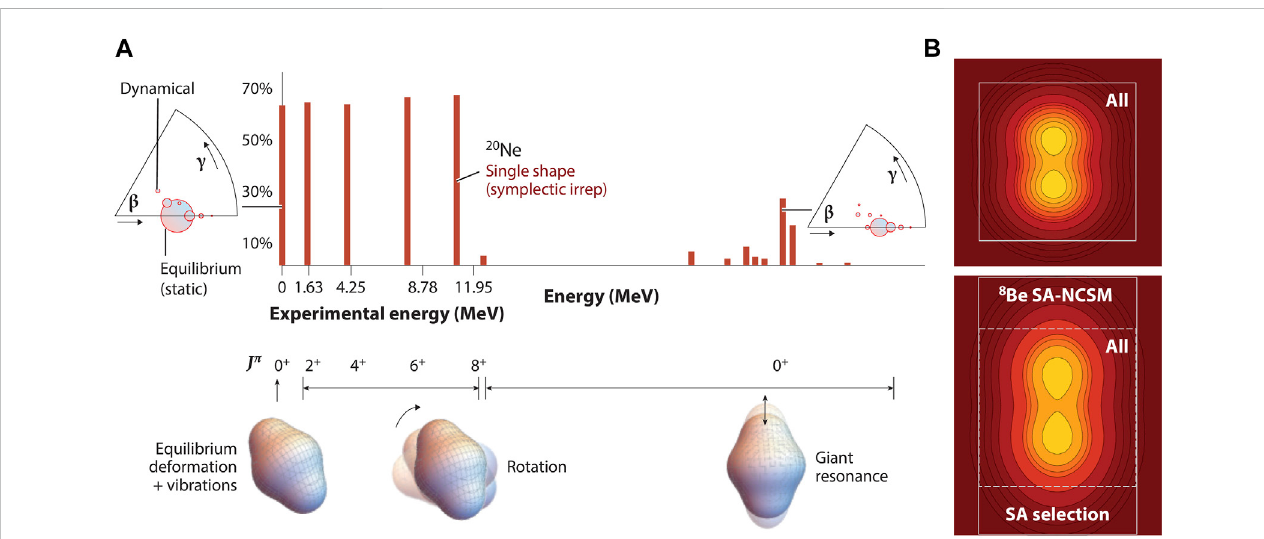
FIGURE 1 (A) Emergent symplectic symmetry in nuclei: Contribution of the most dominant shape to the 0 + ground state of 20 Ne and its rotational band (2 + , 4 + , 6 + , and8 + ),aswellastoexcited0 + states,pointingtoafragmentedgiantmonopoleresonance[8];forselectedstates,thedeformationdistributionwithinashape isshownintermsoftheshapeparameters,theaveragedeformation β andtriaxialityangle γ (basedon abinitio SA-NCSMcalculationswithNNLO opt inamodel space of 11 HO shells with Z Ω = 15 MeV inter-shell distance). (B) Schematic illustration of the SA concept shown for 8 Be: a smaller model space (square) includes all possible shapes (labeled as “ All ” ) and yields spatially compressed wave functions (top); a larger model space (rectangle in lower panel) accommodates, in a well prescribed way, spatially extended modes ( “ SA selection ” ) that are neglected in smaller model spaces. Figure from Ref. [9] under the terms of its CC BY